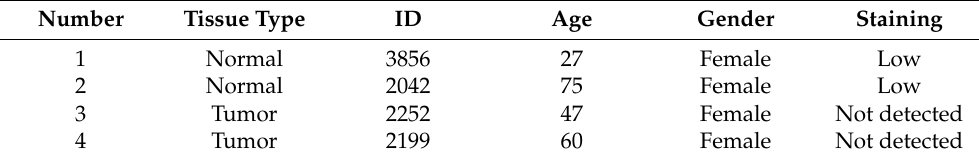
Table 1. Findings of immunohistochemical staining of PTEN in BC in HPA